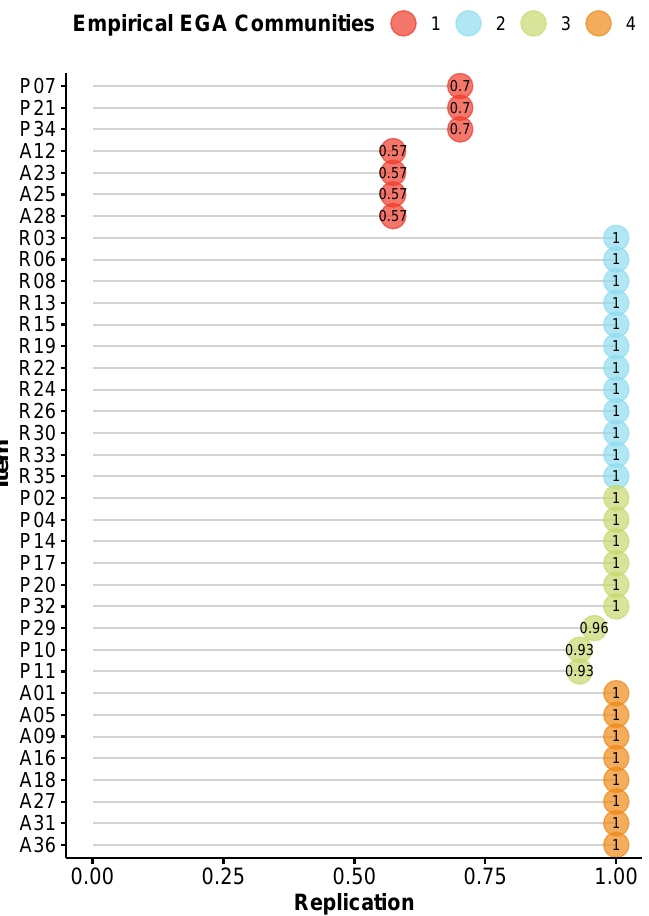
Figure 5. Item stability of the Broad Autism Phenotype